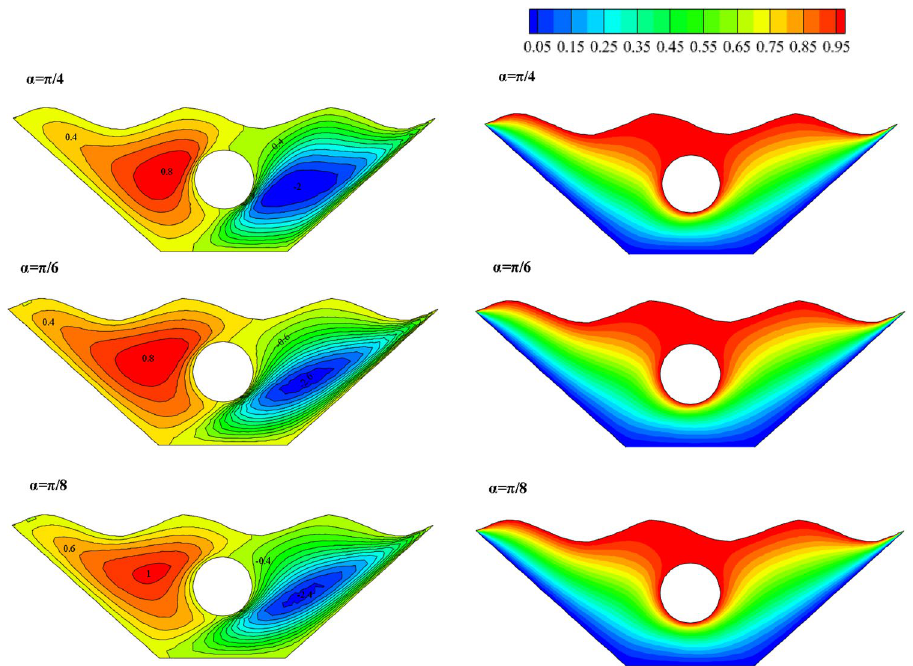
Figure 20. Stream functions and Isotherms for differentangle of magnetic field (α) at ℇ = 0.7, Ra = 500, Ha = 20 and Rd =